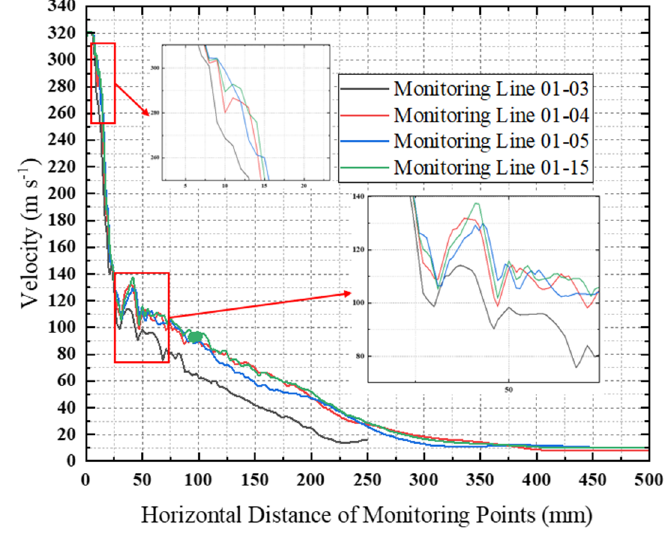
Figure 14. Line chart of the turbulent velocity of the standard nozzle flow field with a compressed air pressure of 212,782 Pa and a temperature of 303 K.4. Study on Correlation of Jet Noise.